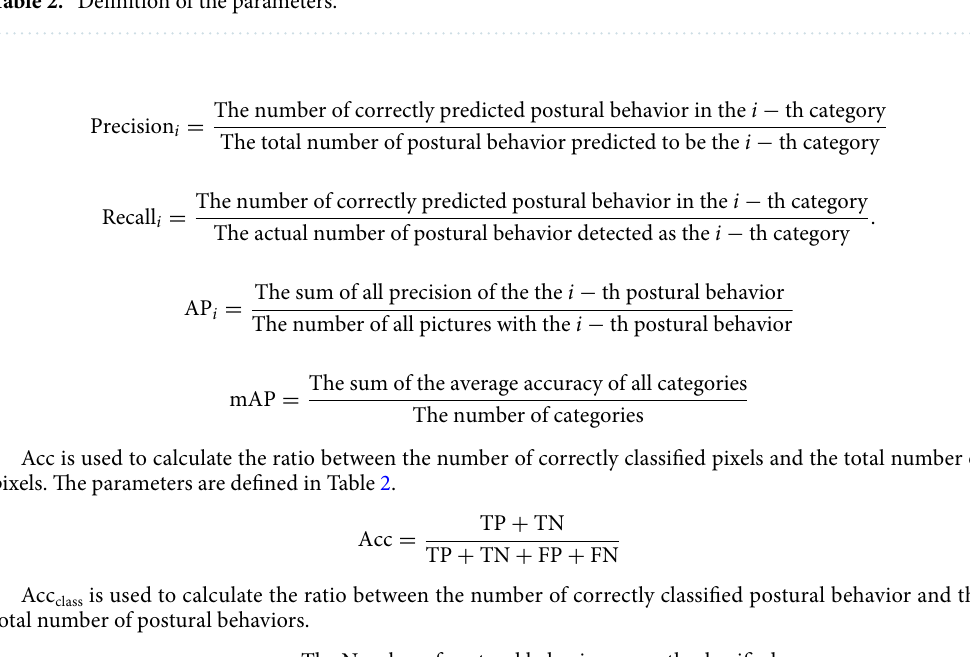
Table 2. Definition of the